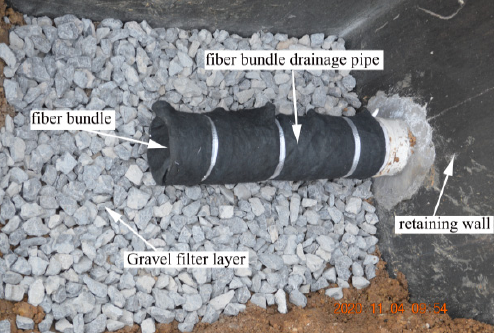
Figure 25. The site arrangement of the fiber bundle drainage pipe.